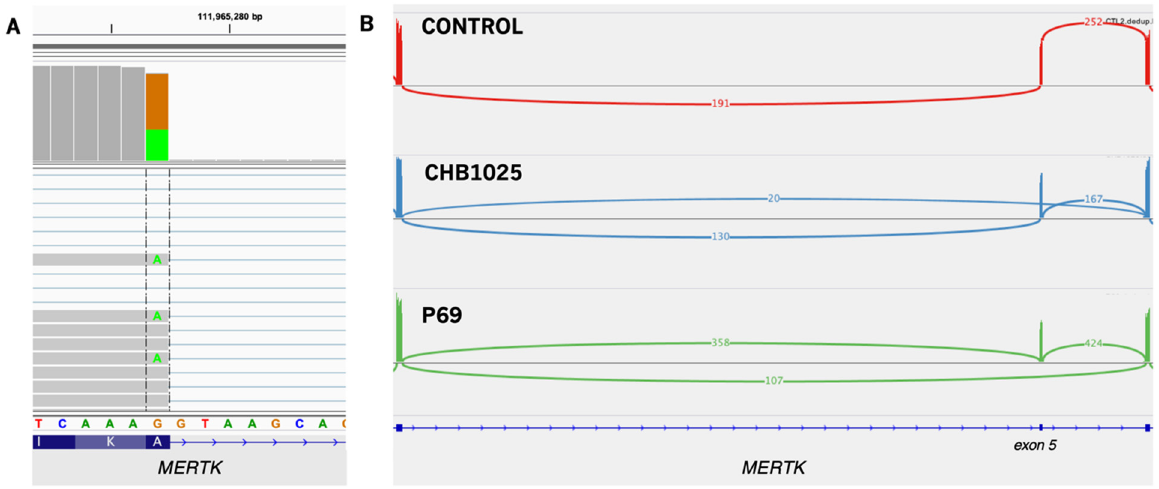
Figure 4. “Leaky” exon skip in MERTK. ( A ) The A282T variant is visible at the end of exon 5. About 33% of reads mapping to this location have the G>A change and splice normally. ( B ) Sashimi plot showing the skip of exon 5 in patients CHB1025 and P69. About 15% of total spliced reads skip exon 5. Sashimi plot shows only the affected and immediately adjacent exons.